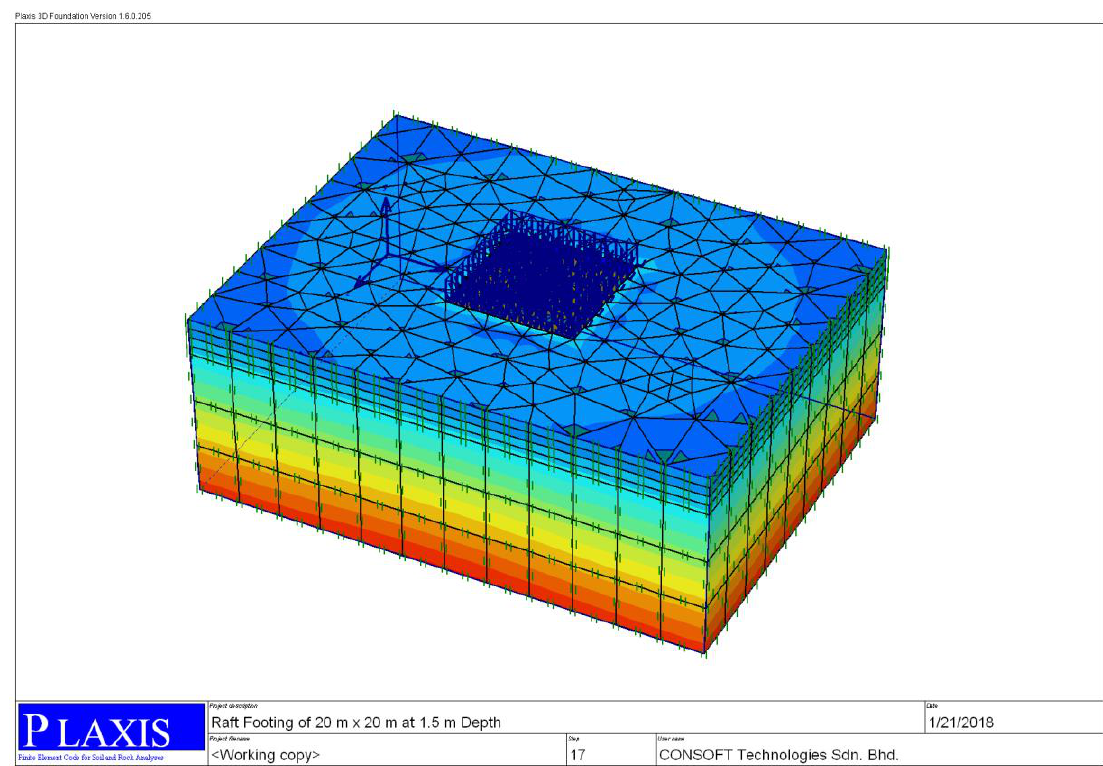
Fig. 3. 3D soil model used for numerical